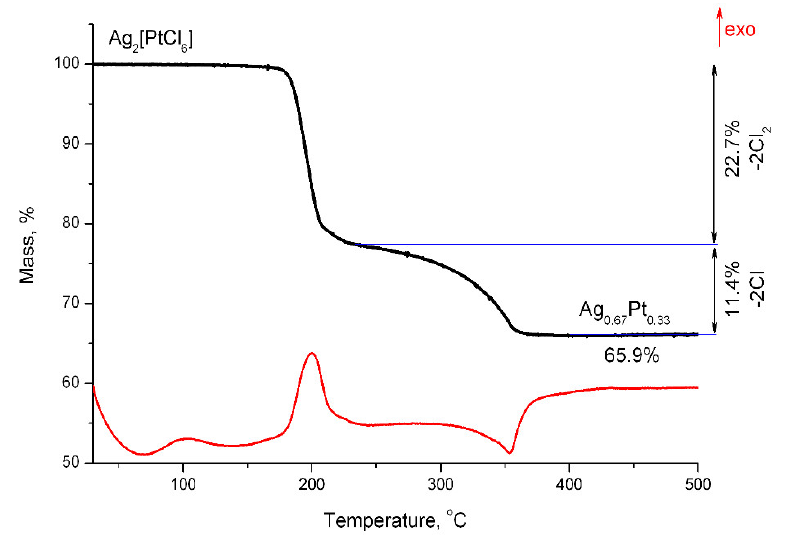
Figure 6. Mass loss curves and differential thermal analysis of Ag 2 [PtCl 6 ] in a hydrogen atmos- phere.